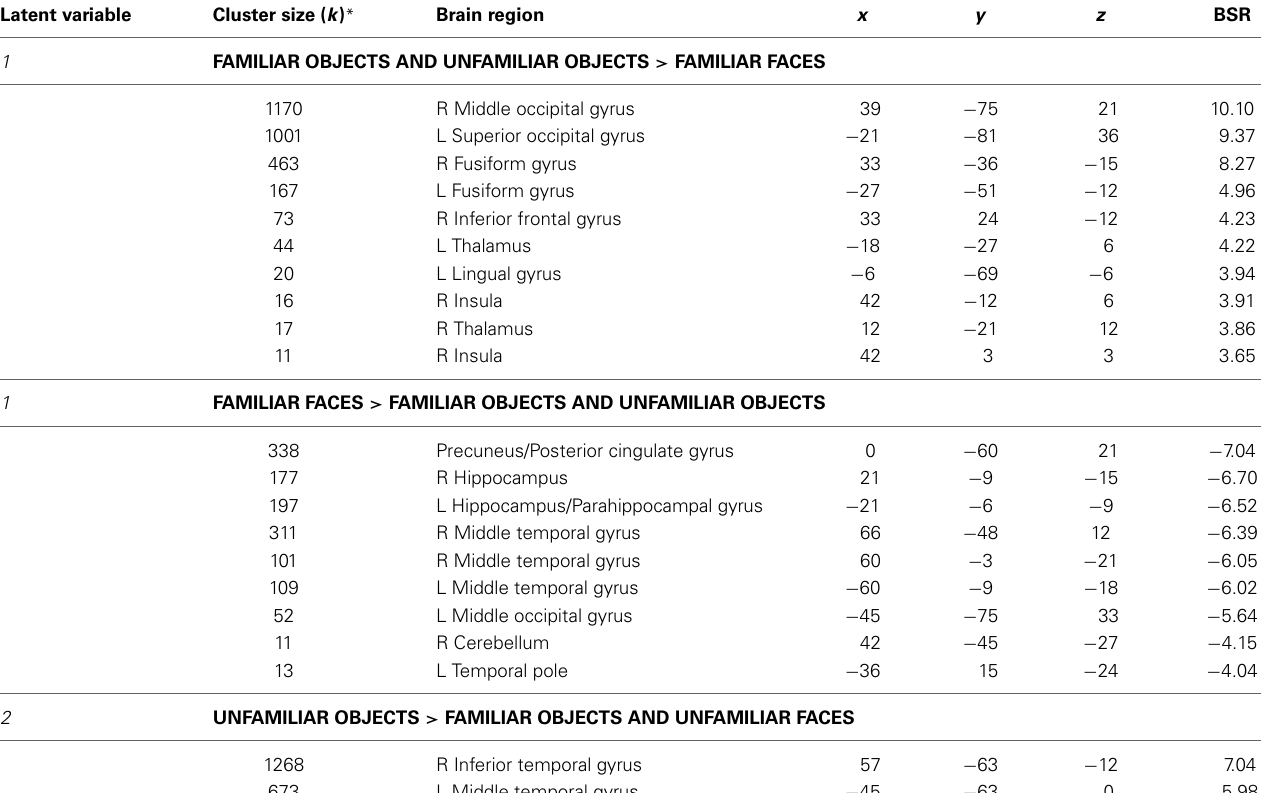
Table 2 | Regions associated with the latent variables from the mean-centered task PLS analysis. Latent